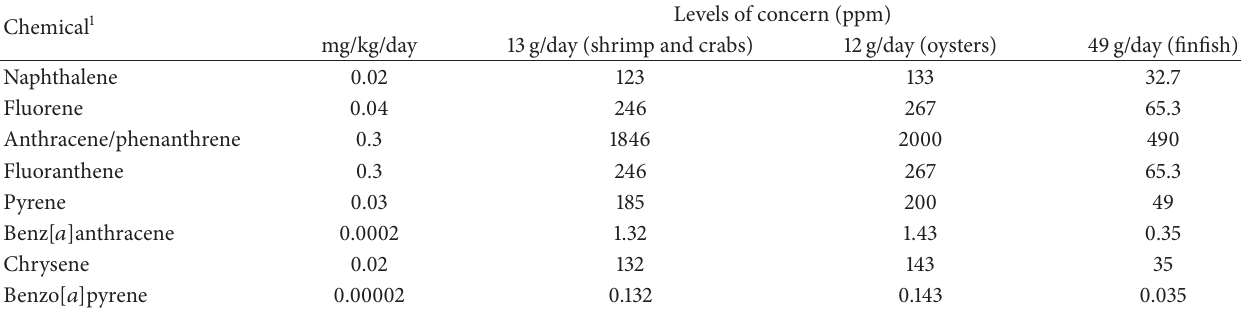
Table 1: United States PAH regulatory limits for reopening impacted